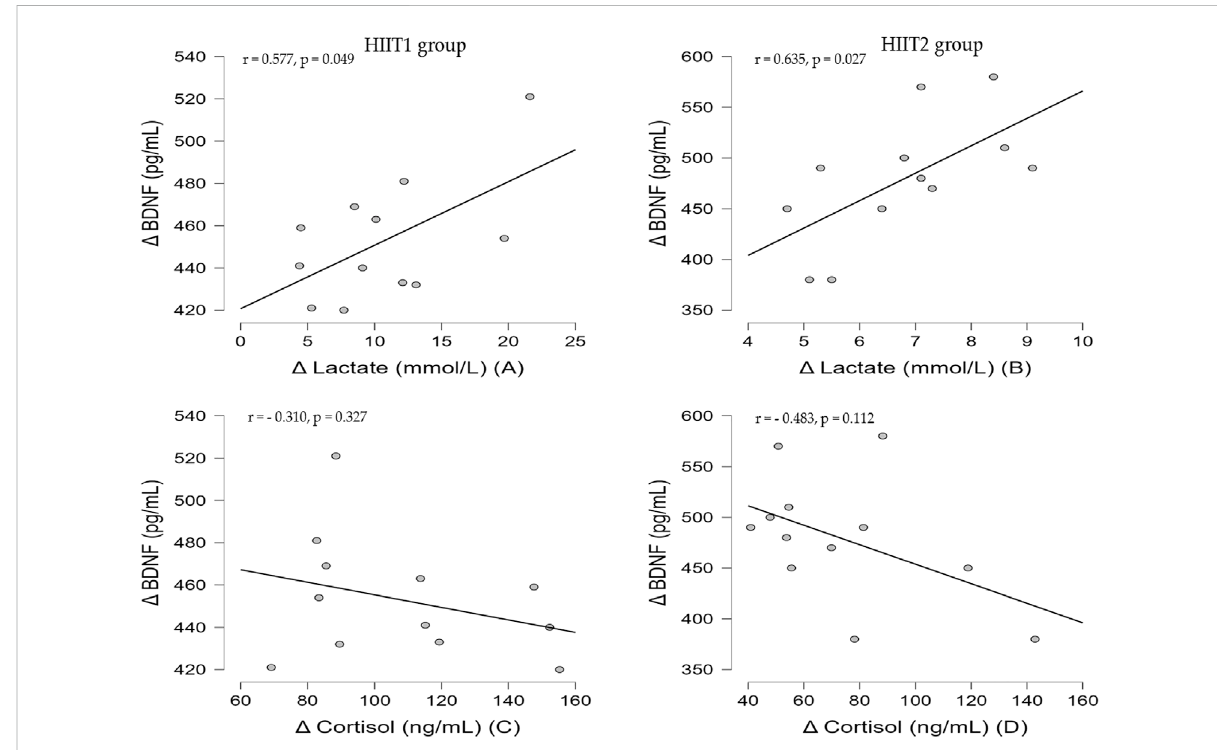
FIGURE 4 Correlation between delta value in blood lactate, serum cortisol and serum BDNF for HIIT1 group (A and C) and HIIT2 group (B and D)